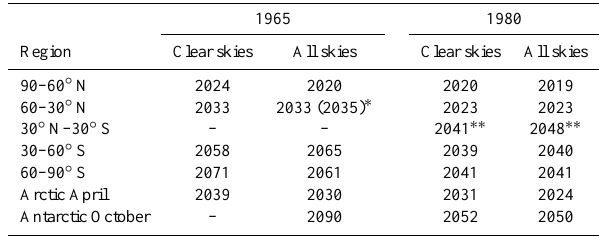
Table 3. Return years of multi model mean annual erythemal irra- diance to its levels in 1965 and 1980, for different regions and for clear- and all-sky conditions. Return years for monthly means are shown only for Arctic and Antarctic